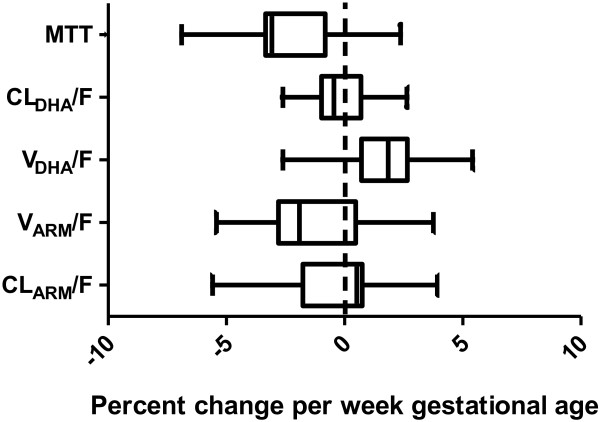
Boxplots (2.5 - 97.5 percentiles) visualising the effect of estimated gestational age on pharmacokinetic parameters. Mean transit time (MTT), apparent volume of distribution dihydroartemisinin (VDHA/F), elimination clearance (CLDHA/F), apparent volume of distribution artemether (VARM/F) and elimination clearance artemether (CLARM/F) from 250 bootstrap runs.